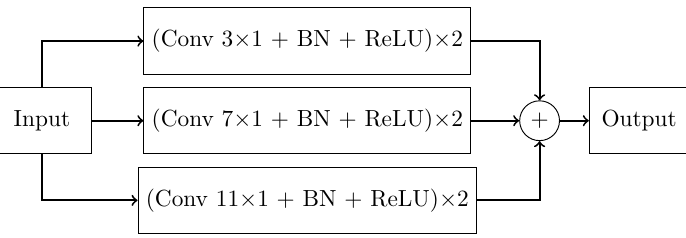
Figure 5. Inception block.